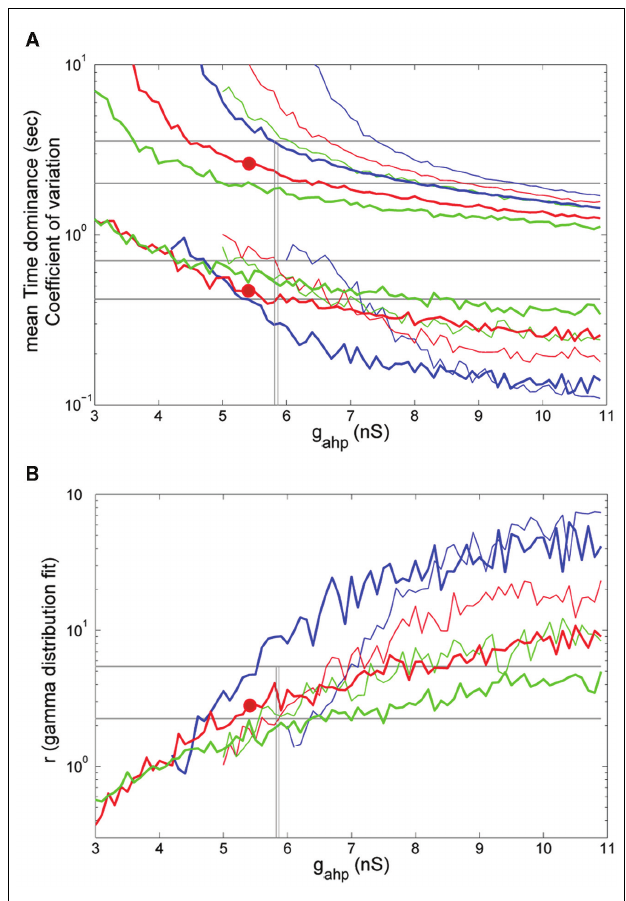
FIGURE 8 | (A) Mean time dominance and coefficient of variation as a function of neuronal adaptation for different levels of noise (blue: n = 0.01, red: n = 0.014 and green: n = 0.016) for λ 1 = λ 2 = 40Hz (thin lines) and λ = λ = 50Hz (thick lines). (B) Parameter r of gamma distribution fit to the 1 2 distribution of dominance times as a function of neuronal adaptation for the same levels of noise as in (A) . In both (A,B) , horizontal lines denote the range that the experimental data define.Vertical lines are drawn at the bifurcation points where the system transits from a bistable dynamical regime to a mixed-mode oscillations and to an oscillatory regime. Red big circles at g ahp = 5.4nS, n = 0.014 indicate a case for which the model replicates the experimental data.